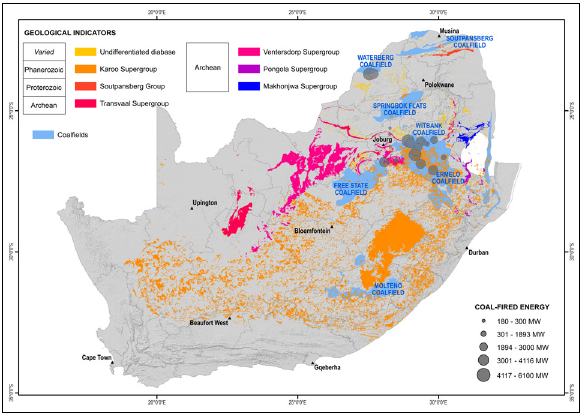
Overview of surface expression of significant basaltic sequences across South Africa together with coalfields and coal-fired energy generation plants. Data from the Council for Geoscience Data Portal.